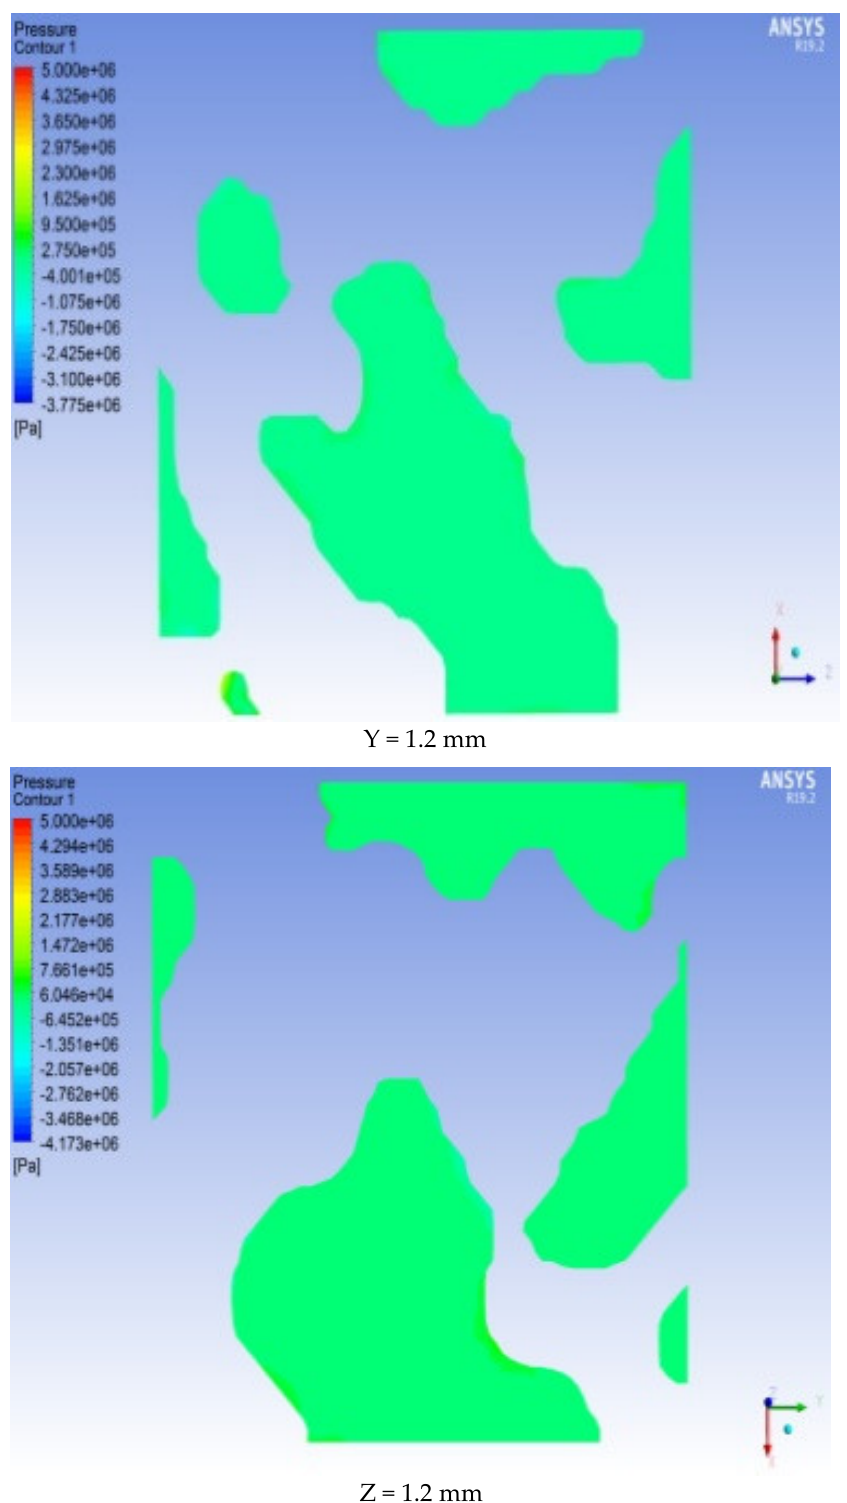
Figure 13. X, Y, and Z positive single channel seepage pressure cloud diagram of different cross-sections.